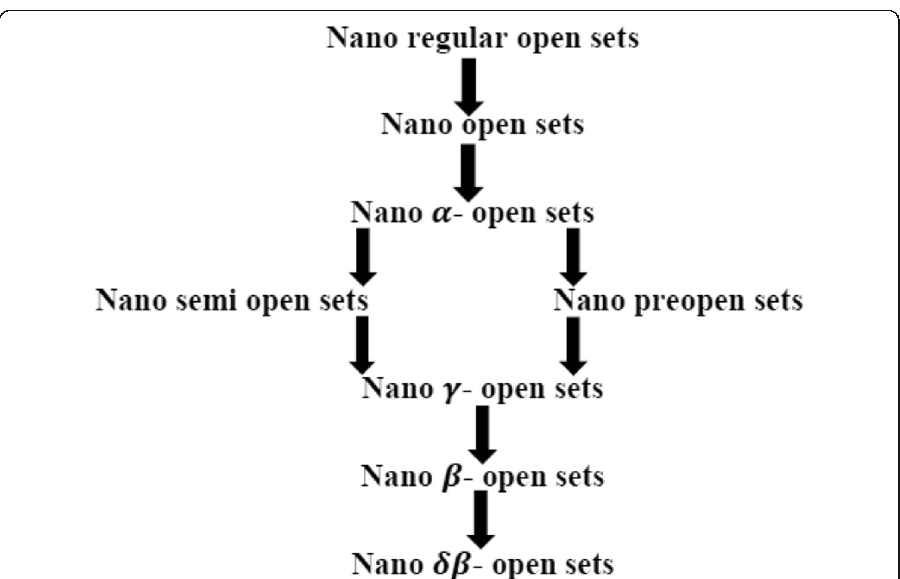
Fig. 1 The relationships between nano near open